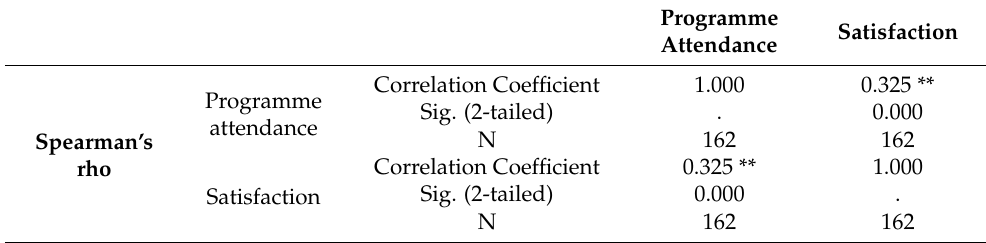
Table 5. Spearman correlation coefficient between programme attendance and satisfaction level.